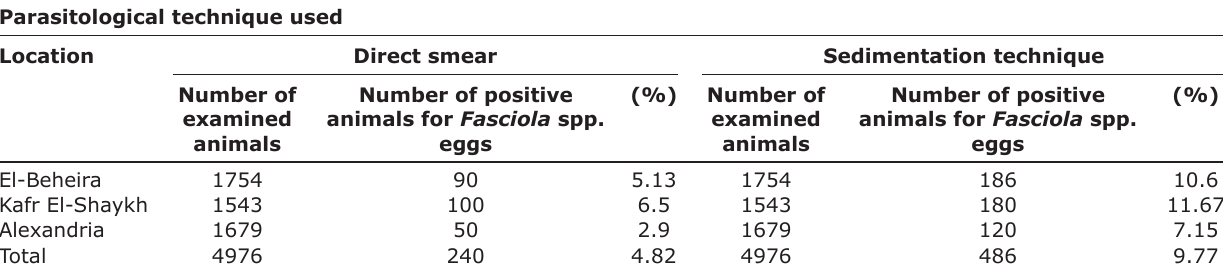
Table-2: Comparison of prevalence rates according to parasitological examination technique used. Parasitological technique